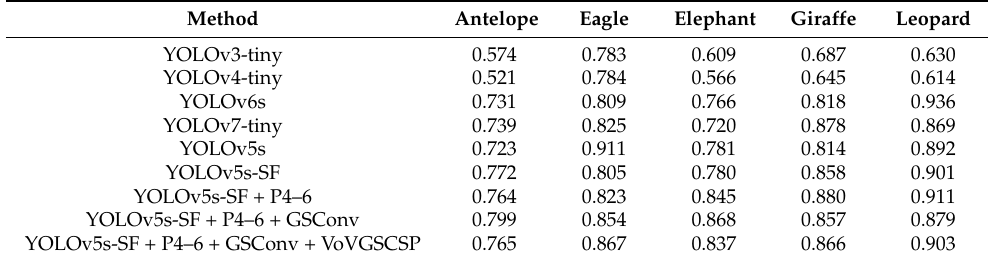
Table 5. The AP value of each model in a single category in the ablation experiment. Method Antelope Eagle